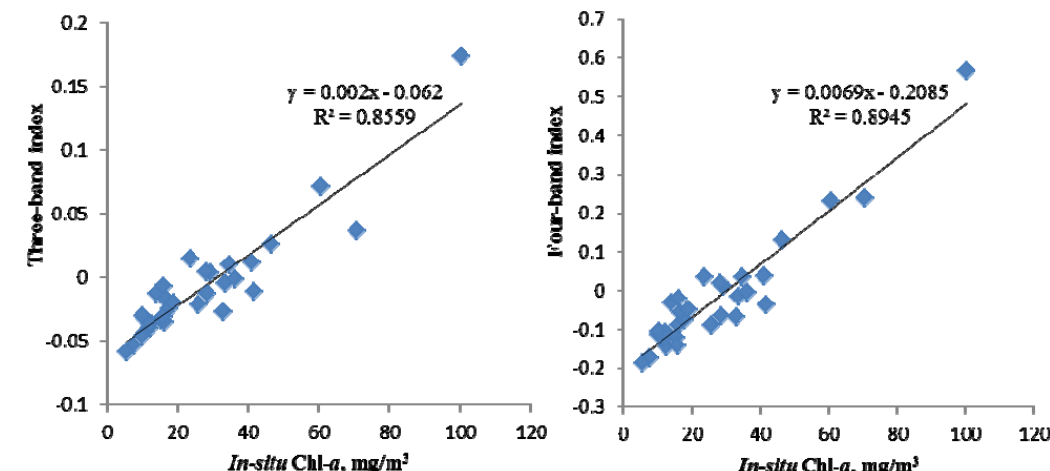
Figure 6. Accuracy assessment of the two indices with simulated bands of Hyperion. ( a ) Three-band index; ( b ) Four-band